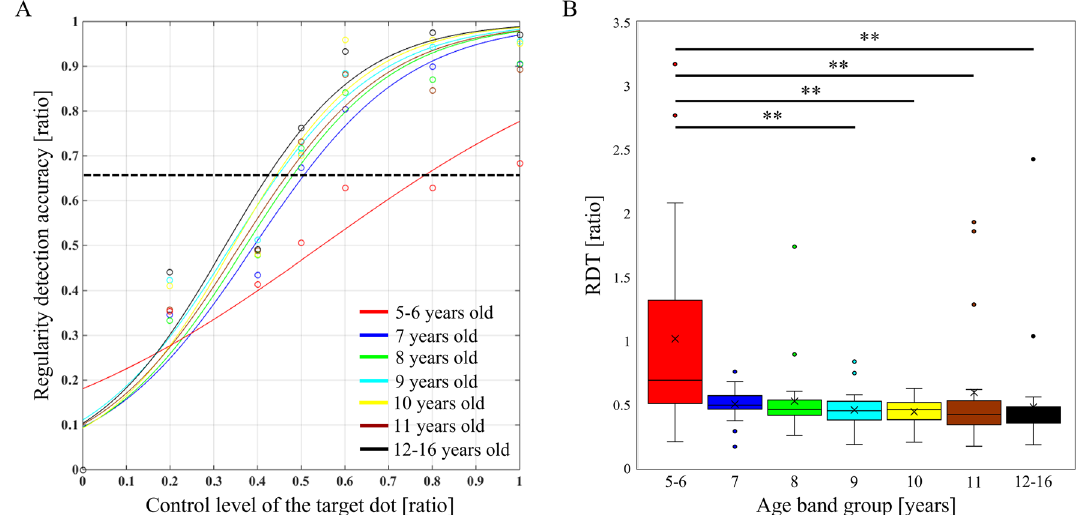
Figure 2. Detection probability curves of action-outcome regularity in each age group and their comparison. ( A ) The colored curves show the detection probability curves of action-outcome regularity for each age group. The black dashed line represents the action-outcome regularity detection threshold (66.6%). ( B ) Comparative results of the regularity detection threshold (RDT) for each age group. Lines represent the range of the minimum and maximum. Boxes represent the lower, median, and upper quartiles. * p < 0.05, ** p <